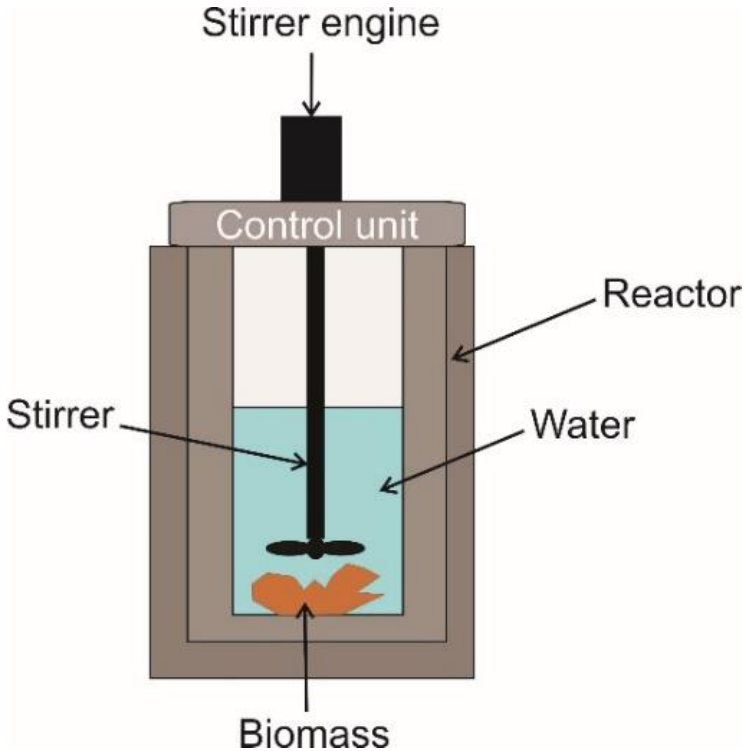
Figure A3. Schematic representation of a reactor for the hydrothermal carbonization of biomasses.